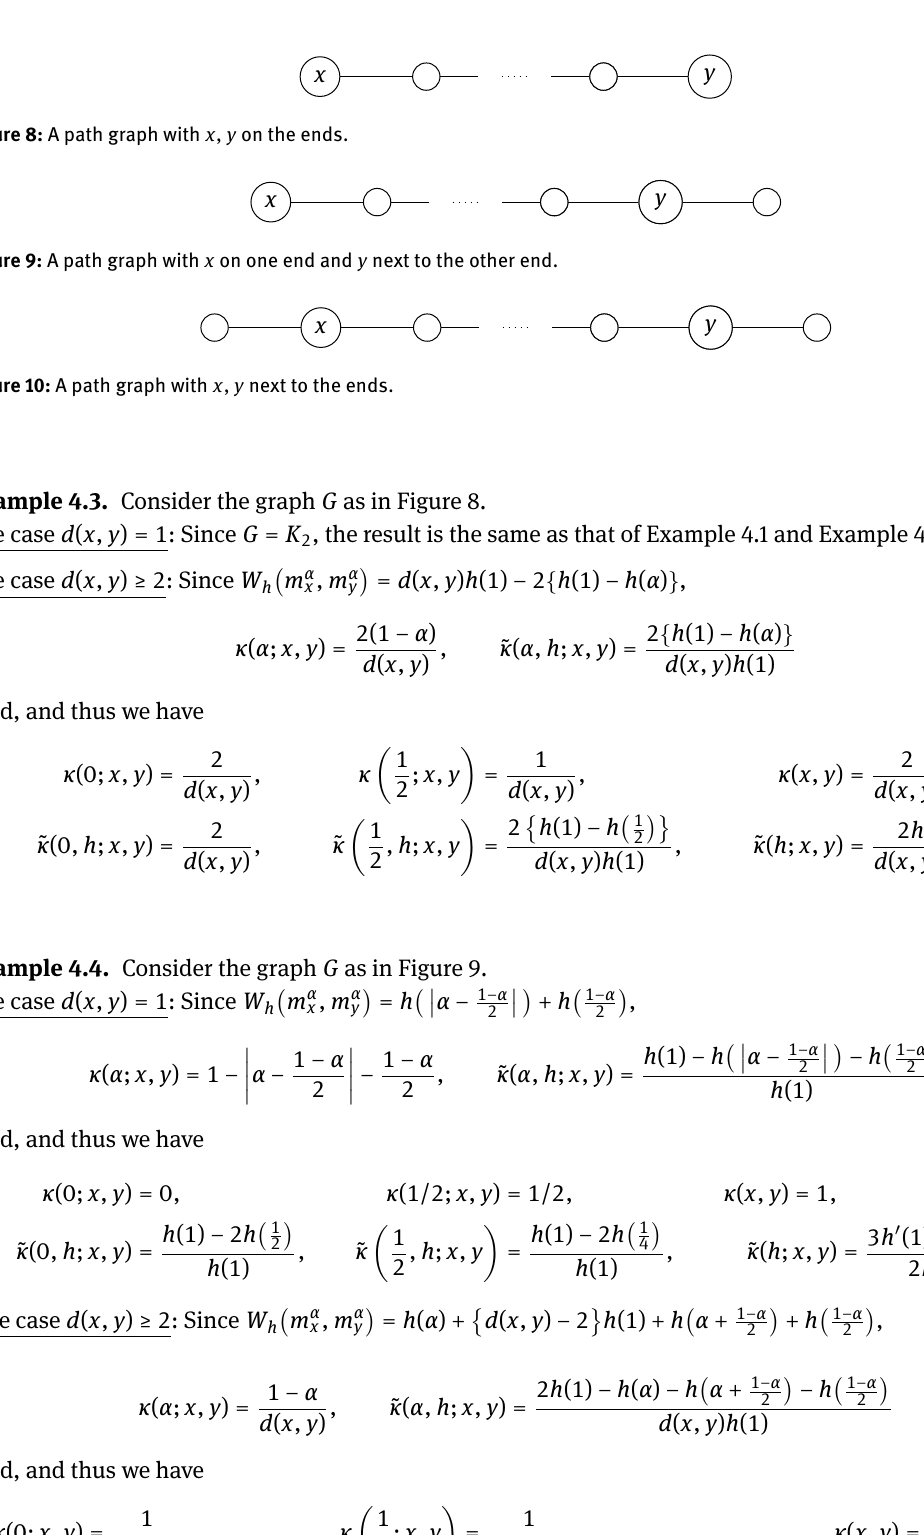
Figure 8: A path graph with x , y on the ends.